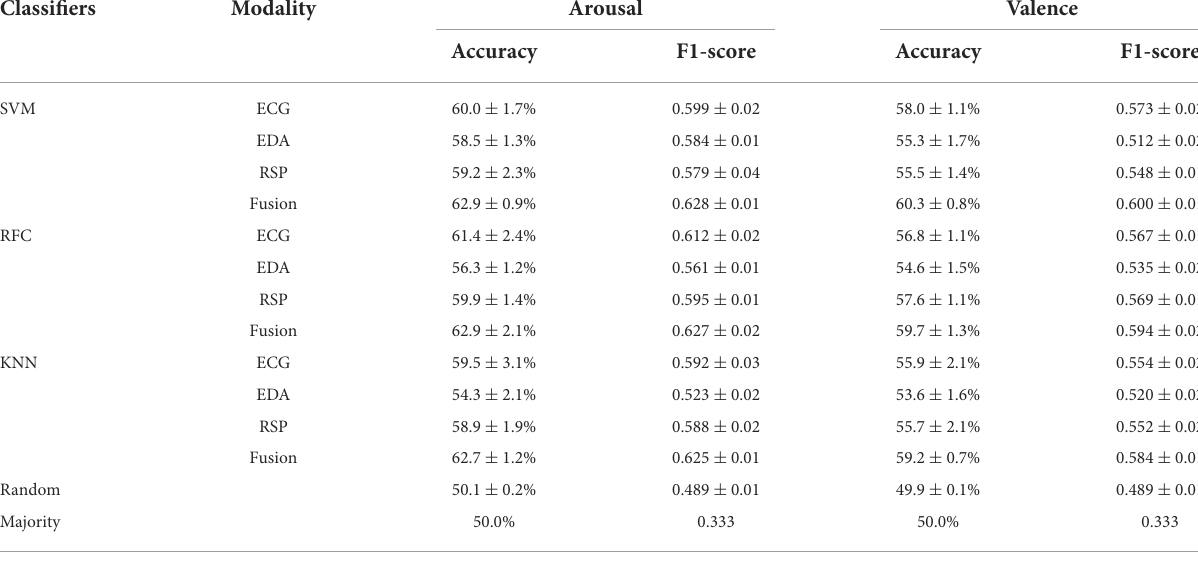
TABLE 6 Comparison with other public